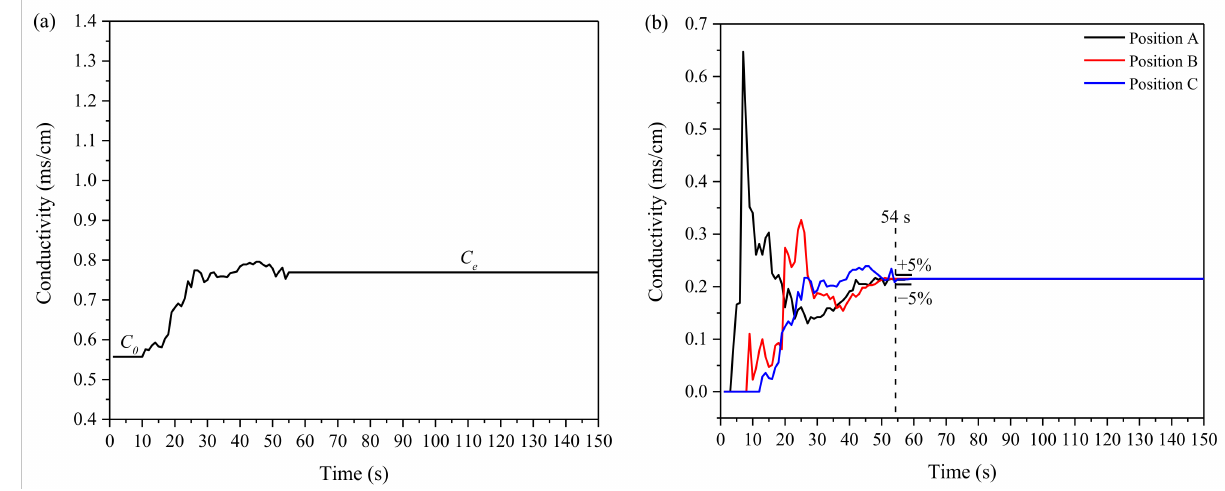
Figure 3. Conductivity curve of ( a ) water and tracer and ( b ) conductivity curves of tracer with dual bottom plugs under the flow rate of 1.2 m 3